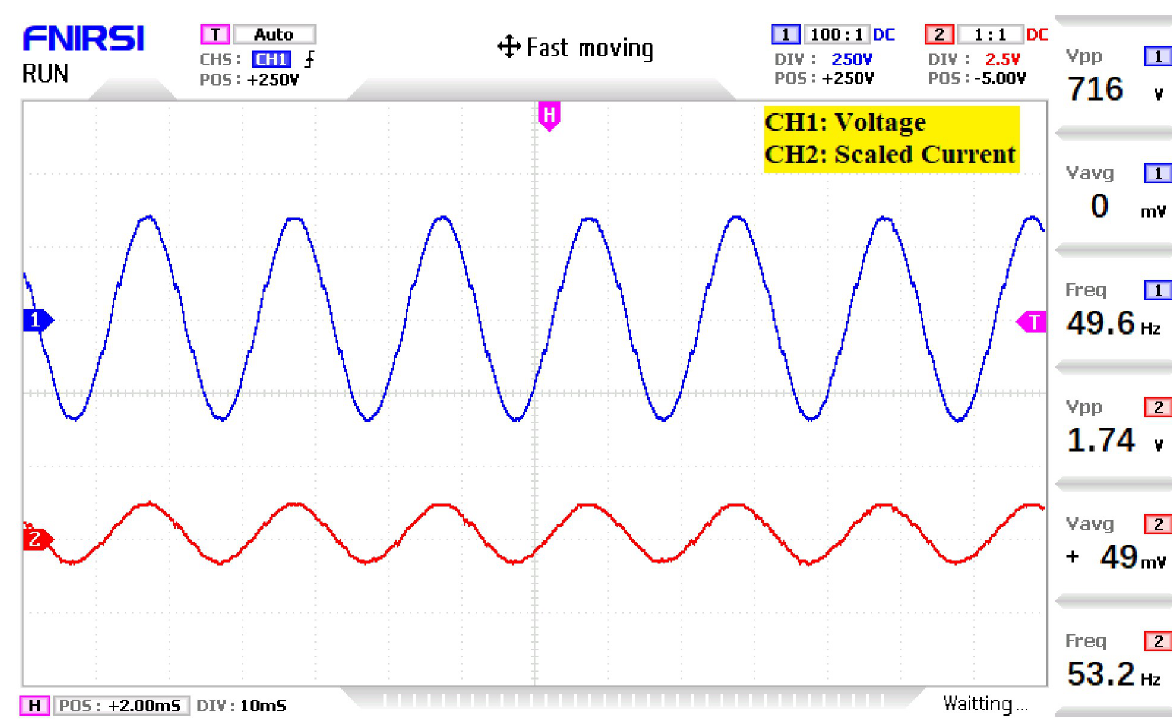
Fig 24. Experimental waveforms (voltage and current) at the output of 81-level MWMLI for MI = 0.88 at unity PF load.